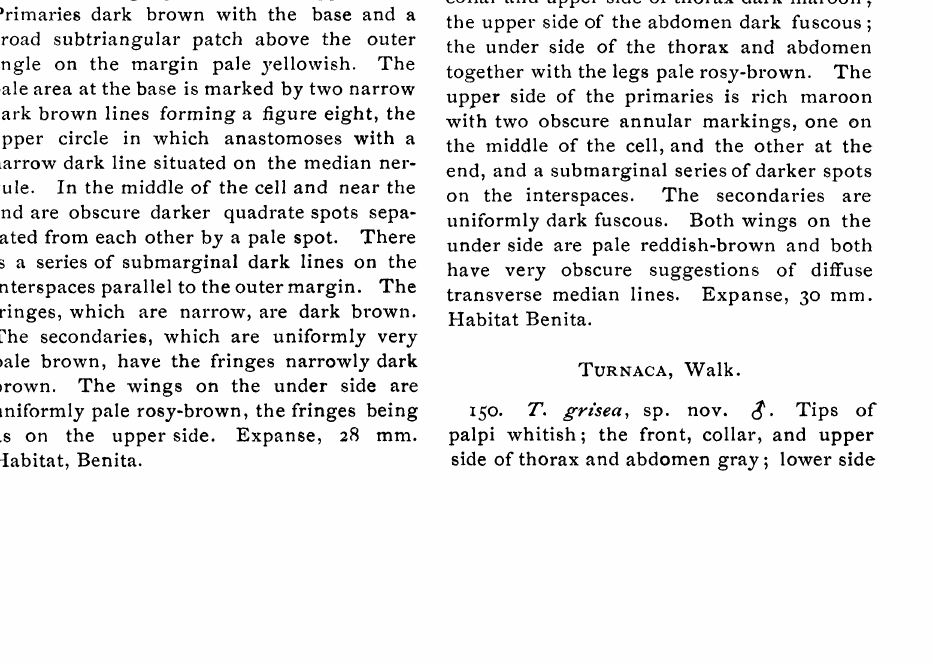
. Front, collar, and anterior edge of patagia dark brown posterior edge of patagia light rosy- brown; upper side of thorax and abdomen rosy-fawn; lower side of the abdomen and of the legs similarly colored. Upper side: the primaries are pale rosy-brown, darkest on the costa and at the apex. On the middle and at the end of the cell, are two obscure subquad- rate spots of darker brown margined exter- nally and internally by very fine parallel lines. Below the spot in the middle of the cell, there is a dark blackish subquadrate spot. There is a regular series of fine submarginal lines on the interspaces arranged in echelon from the apex to the outer angle. The sec- ondaries are whitish slightly tinged with pale pinkish. Under side: both primaries and secondaries are uniformly pinkish-white. Expanse, 3 8 ram. relatively short and broad front dark brown occiput yellowish patagia and upper side of thorax dark brown; upper side of abdomen lighter brown; under side of thorax and ab- domen and legs pale brown. Upper side: Primaries dark brown with the base and a broad subtriangular patch above the outer angle on the margin pale yellowish. The pale area at the base is marked by two narrow dark brown lines forming a figure eight, the upper circle in which anastomoses with a narrow dark line situated on the median ner- yule. In the middle of the cell and near the end are obscure darker quadrate spots sepa- rated from each other by a pale spot. There is a series of submarginal dark lines on the interspaces parallel to the outer margin. The fringes, which are narrow, are dark brown. The secondaries, which are uniformly very pale brown, have the fringes narrowly dark brown. The wings on the under side are uniformly pale rosy-brown, the fringes being as on the upper side. Expanse, 28 mm. Habitat,